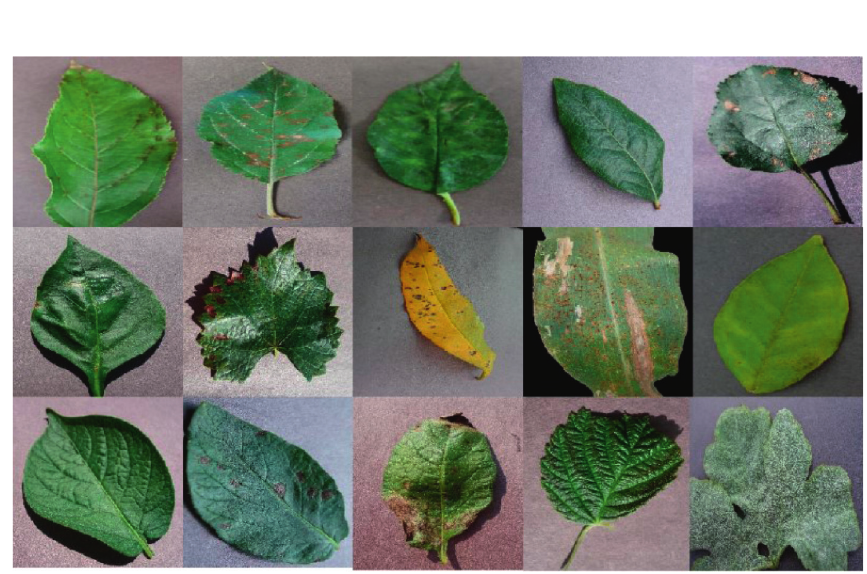
Figure 11: Partial data of PlantVillage.